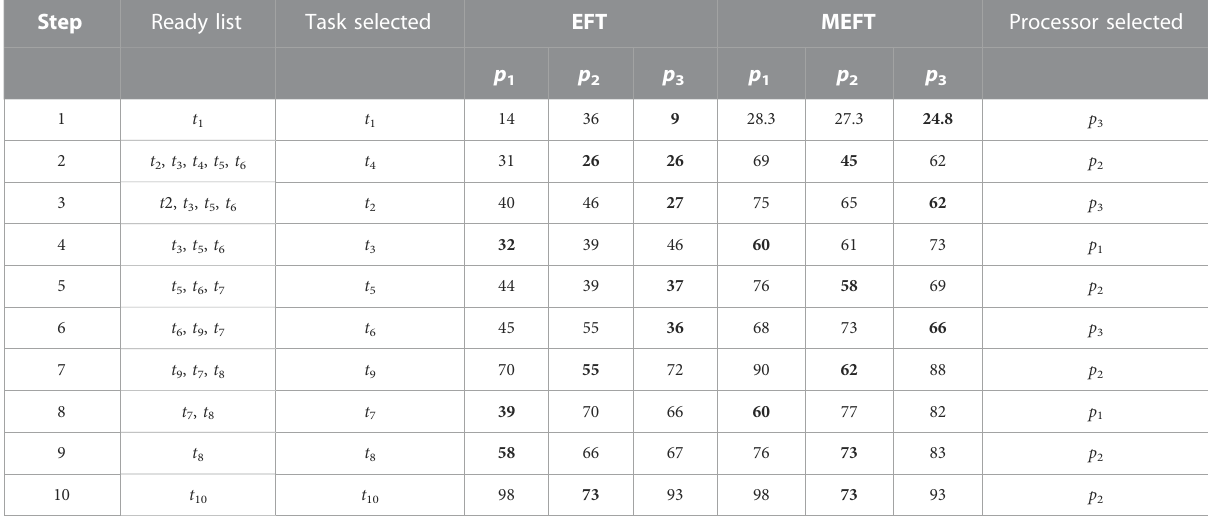
TABLE 4 Schedule Produced by the MPEFT Algorithm in Each Iteration on the sample DAG in Figure 2.